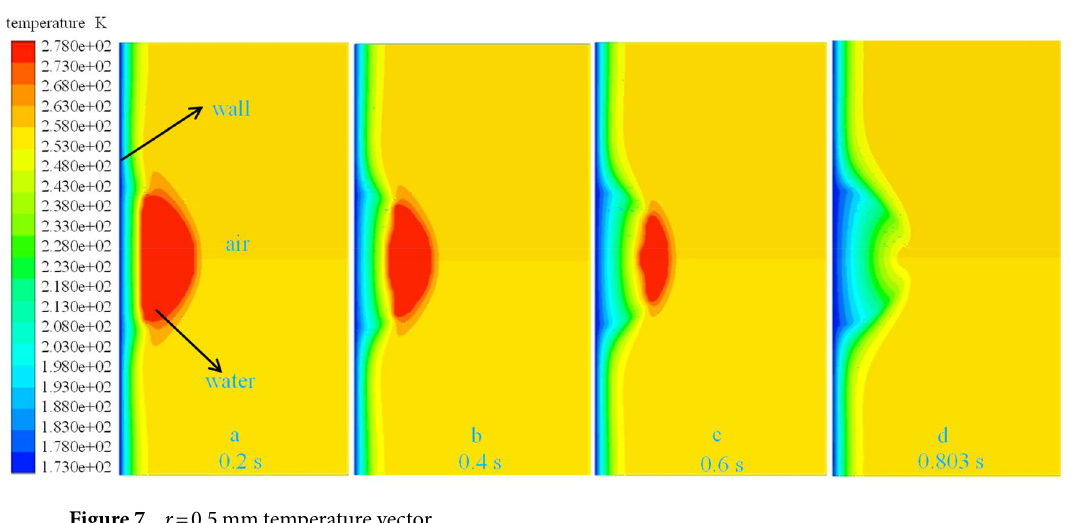
Figure 7. r = 0.5 mm temperature